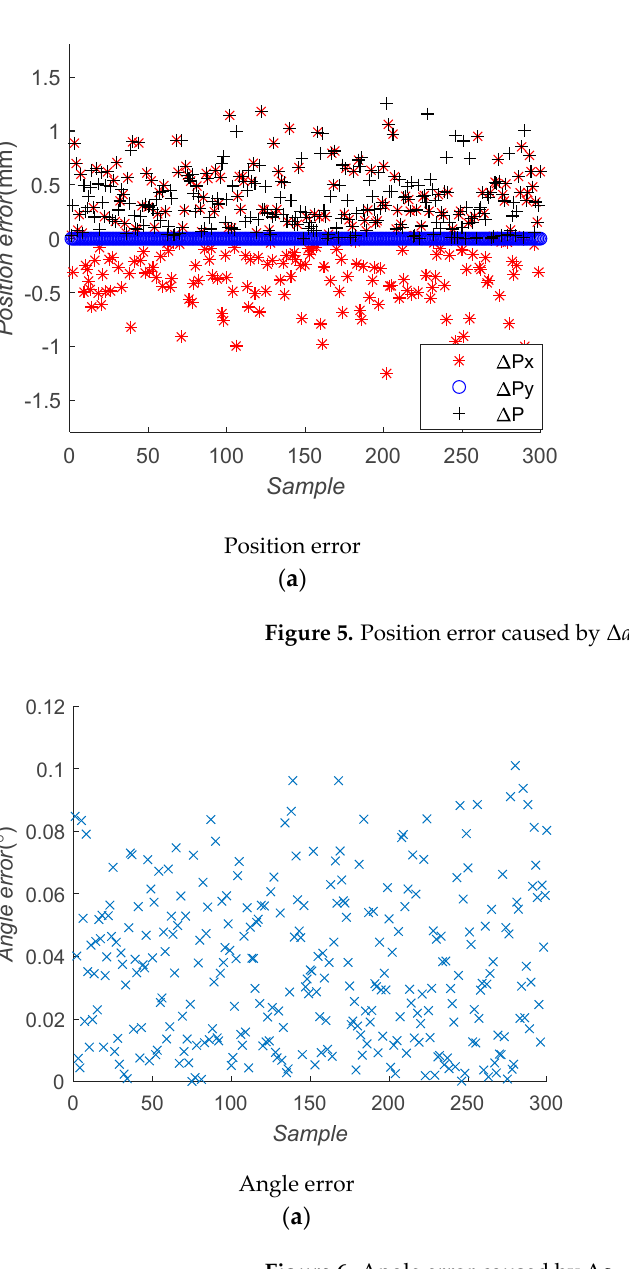
Figure 6. Angle error caused by Δ a i.